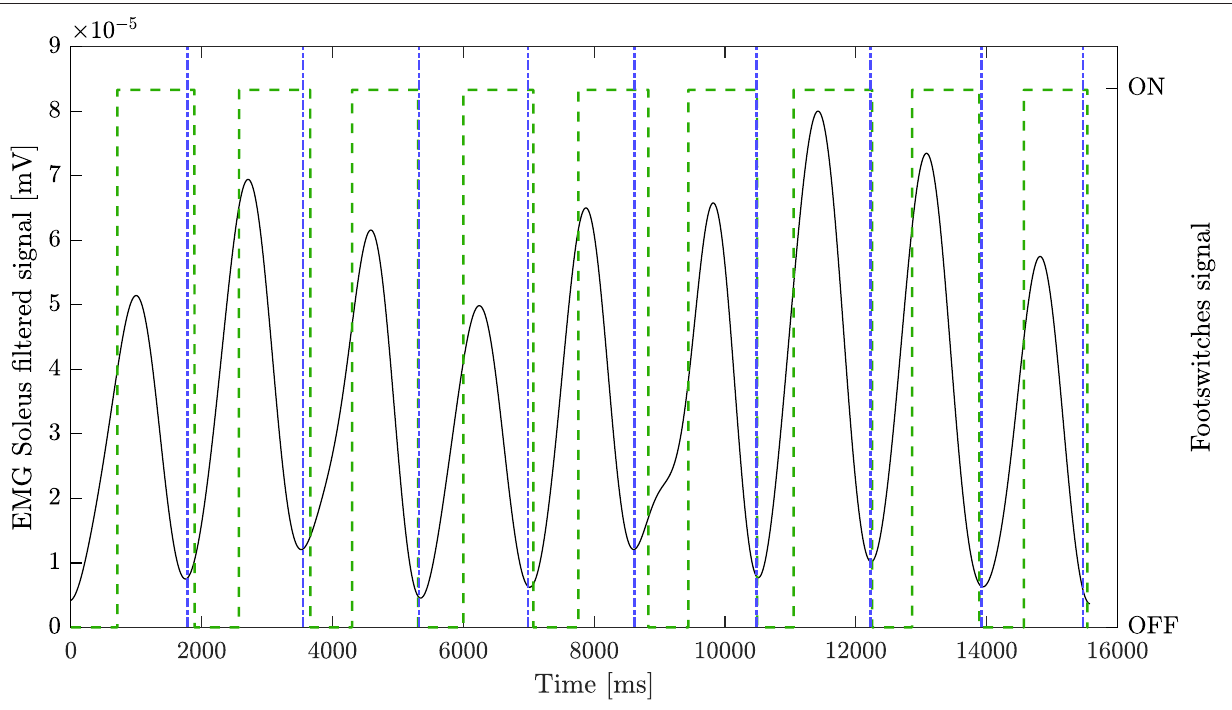
Frontiers in Neurorobotics |